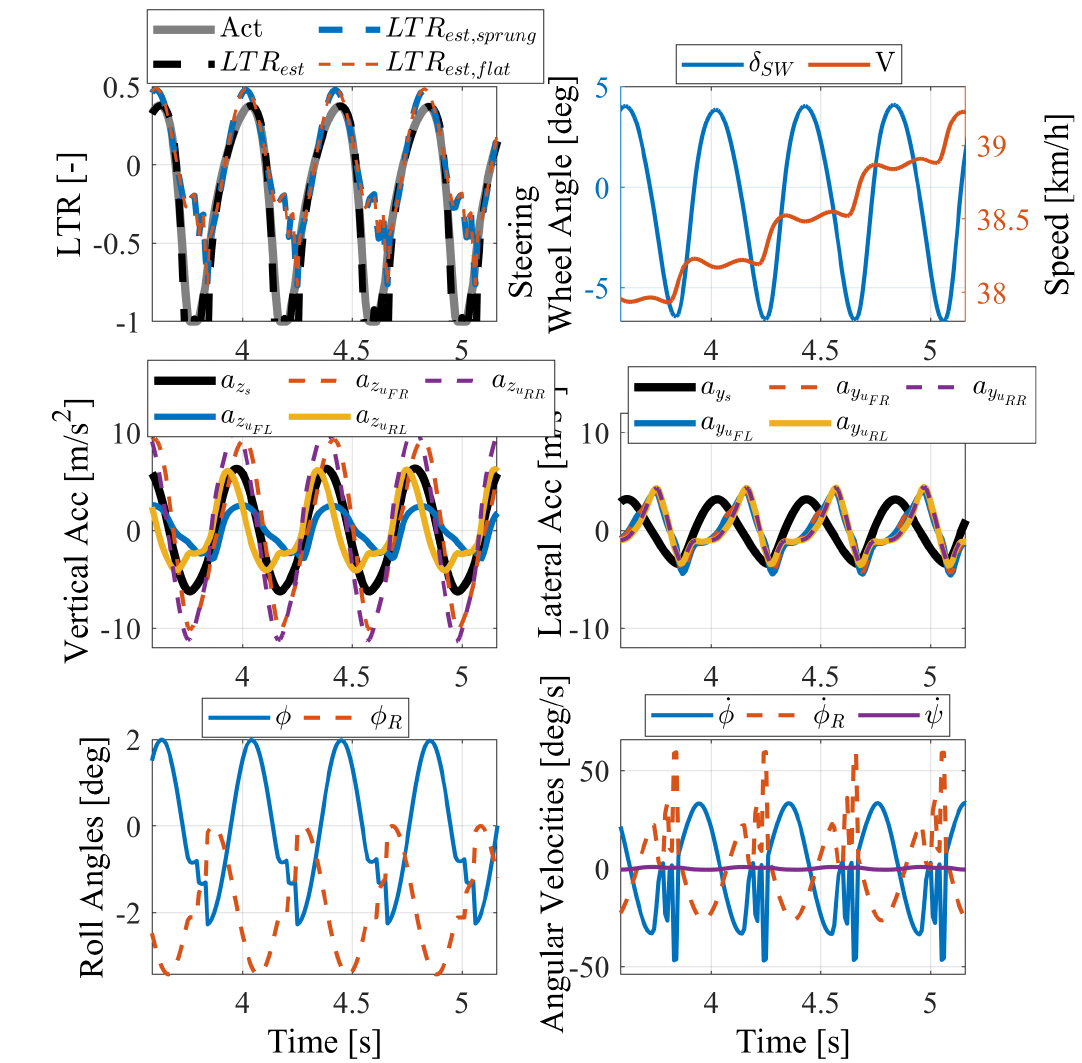
Figure 5. Straight manoeuvre at 40km/h on an asymmetrical waves road. From the top left side to the down right side: LTR , steering wheel angle and vehicle speed, vertical accelerations, lateral accelerations, roll angles and angular